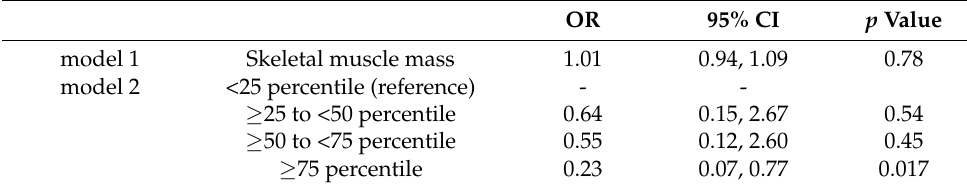
Table 5. Logistic regression analysis of skeletal muscle mass for Agile 3+ score intermediate–high risk.